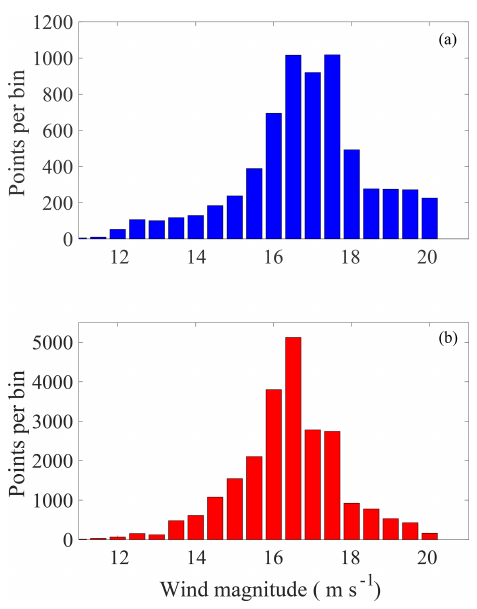
Figure 13. Number of undrogued (a) and drogued (b) drifter posi- tions where the velocity deconstruction was performed, binned by wind velocity magnitude on 0.5ms − 1 intervals. Point velocity mea- surements calculated from drifter trajectories that do not coincide spatially with available data in the pre-existing circulation velocity fields are not